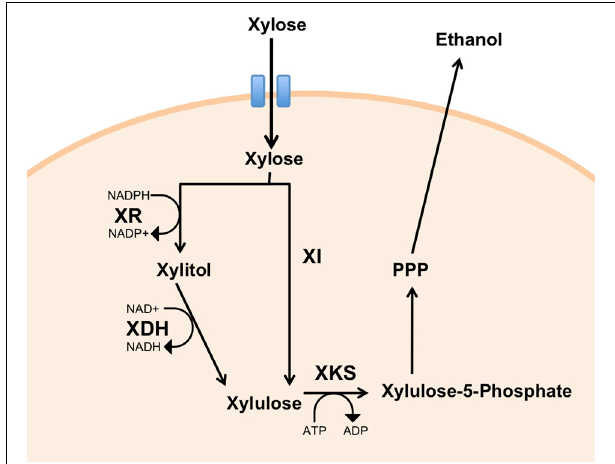
FIGURE 2 | Heterologous expression of xylose metabolic pathways in yeast. Xylose can be metabolized by xylose reductase (XR) and xylitol dehydrogenase (XDH) (Pathway 1), or by xylose isomerase (XI) (Pathway 2) to yield xylulose. Phosphorylation of xylulose by xylulose kinase (XKS) yields xylulose-5-P, which can enter pentose phosphate pathway